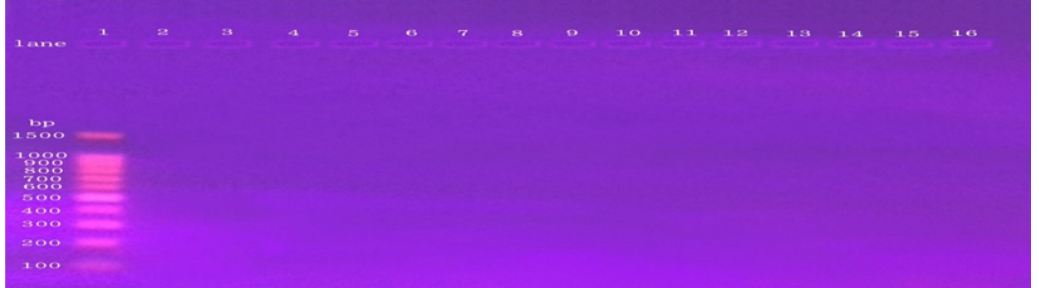
Fig. 5. Gel electrophoresis shows VanA gene